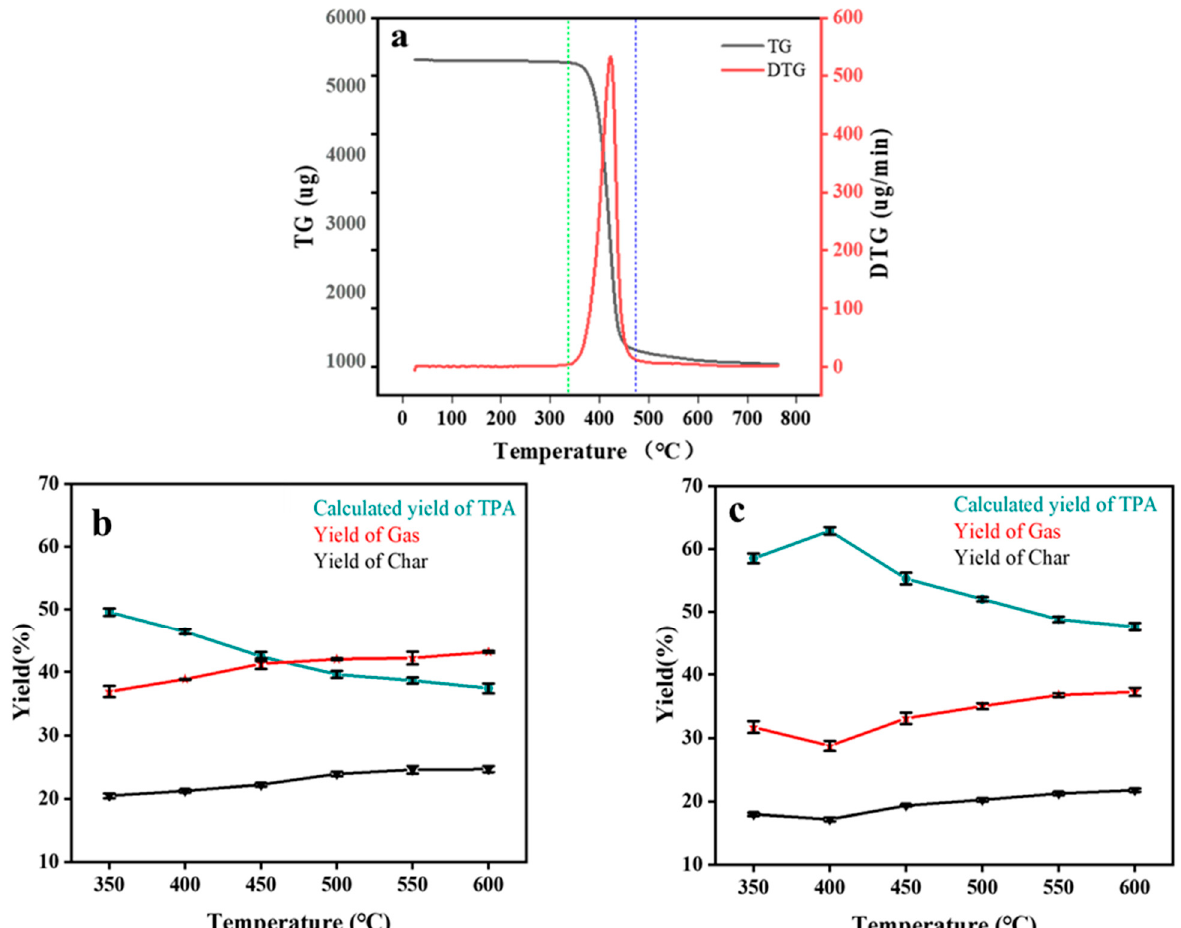
Figure 3. Analysis of PET catalytic conventional pyrolysis products (catalyst—Pt@Hzsm-5; feeding ratio—1:10): ( a ) thermogravimetric analysis (The green line is the initial pyrolysis temperature, and the blue line is the complete pyrolysis temperature); ( b ) product distribution of catalytic pyrolysis at di ff erent temperatures; ( c ) product distribution of the catalytic reforming at di ff erent temperatures.